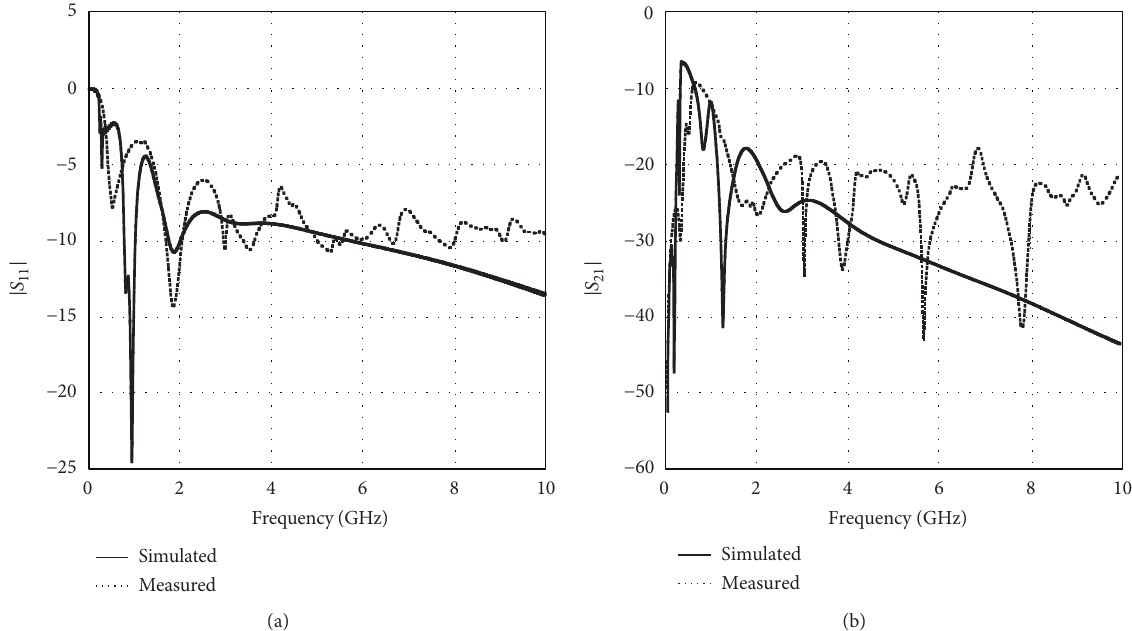
(b) as a function of the frequency. Comparison between simulated and measured results.